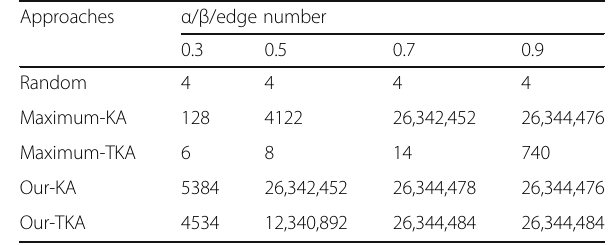
Table 4 The different parameters are employed in the weighted similarity function WJC, and λ = 0.9 to obtain the edge